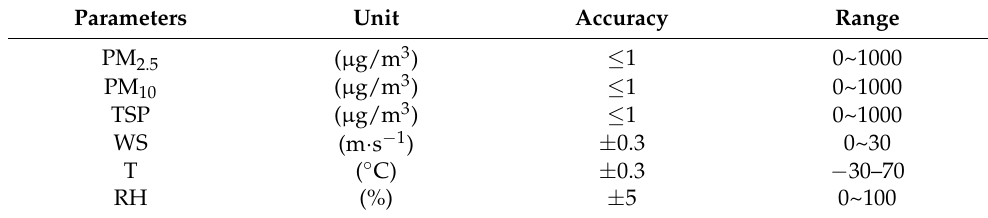
Figure 1. Location of the air quality monitoring station (Latitude: 32°17 ′ N-33°48 ′ N; Longitude: 110°58 ′ E–113°49 ′ E). Table 1. The measuring accuracy and range of parameters in the NYNU site.